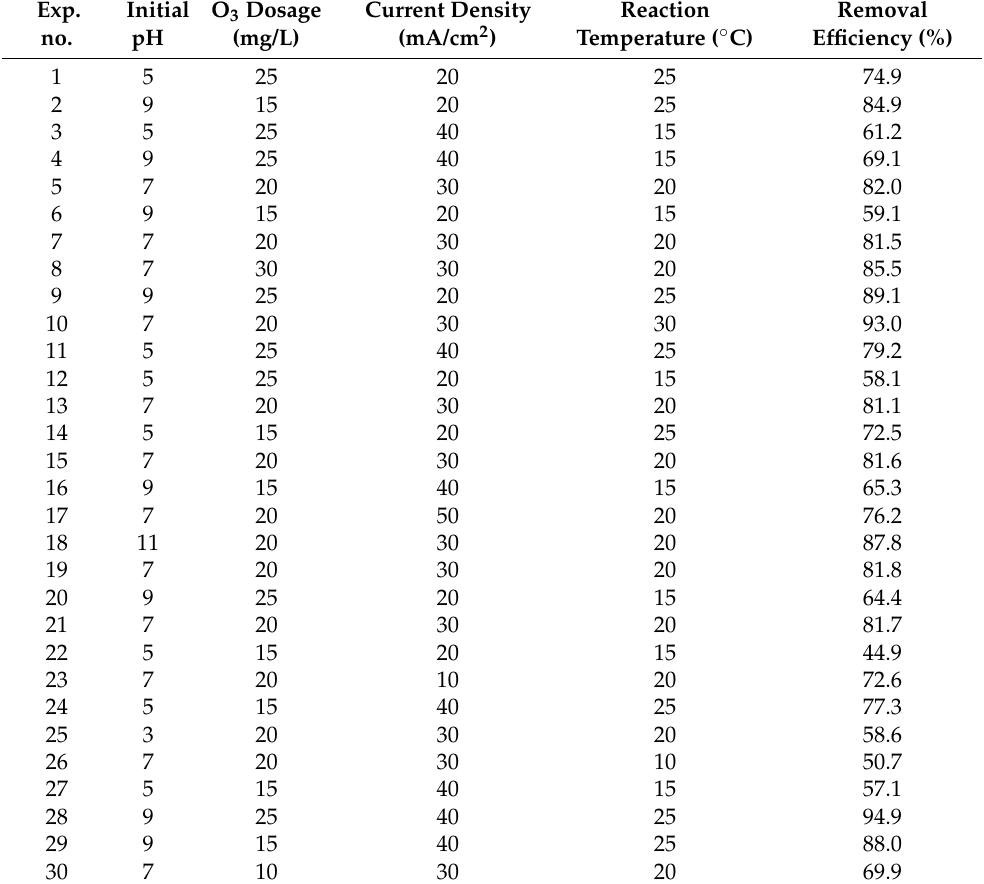
Table 2. Design matrix and the experimental